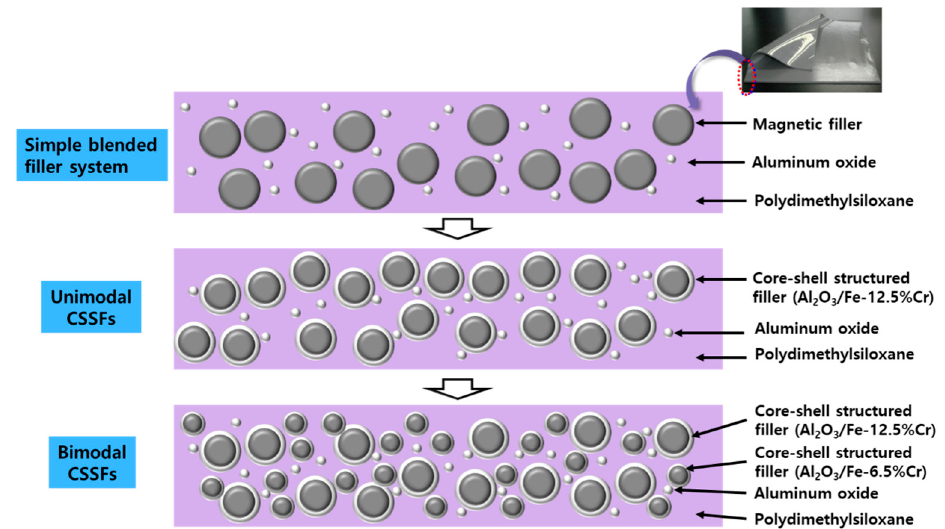
Figure 1. Concepts of three kinds of dual-functional sheets (DFSs) made of simple blended filler systems, unimodal core–shell structured fillers (CSSFs), and bimodal CSSFs.